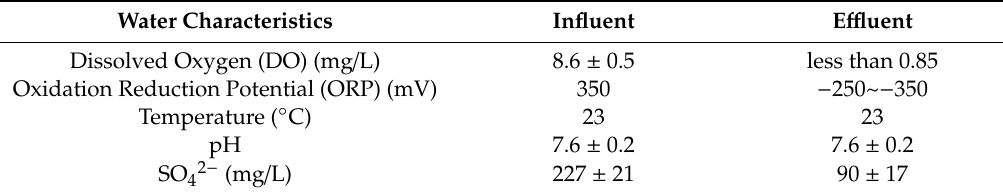
Table 2. Average water characteristics in the membrane-aerated biofilm reactor (MABR).